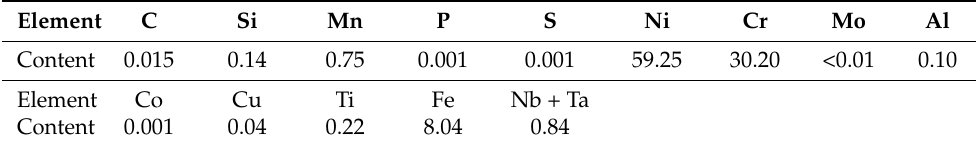
Table 2. Chemical composition of 52M welding wire from SMC (wt%).